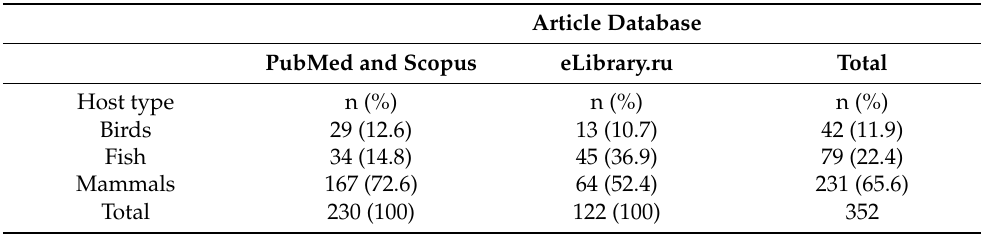
Table 1. Frequency and percentage distributions of host type by bibliographic databases in the included articles (n = 352).